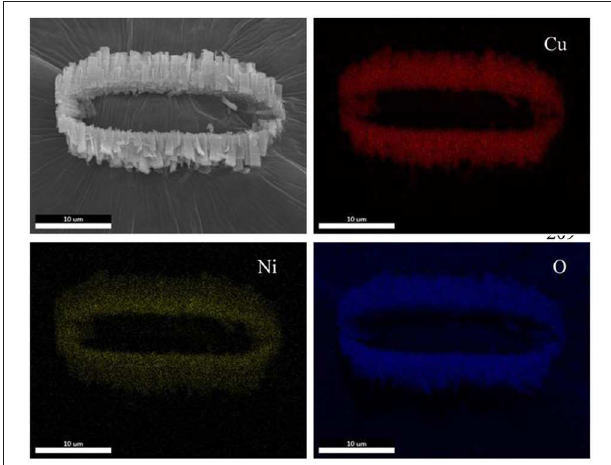
FIGURE 4 | Elemental mapping of Ni 0.4 Cu 0.6 O catalyst.